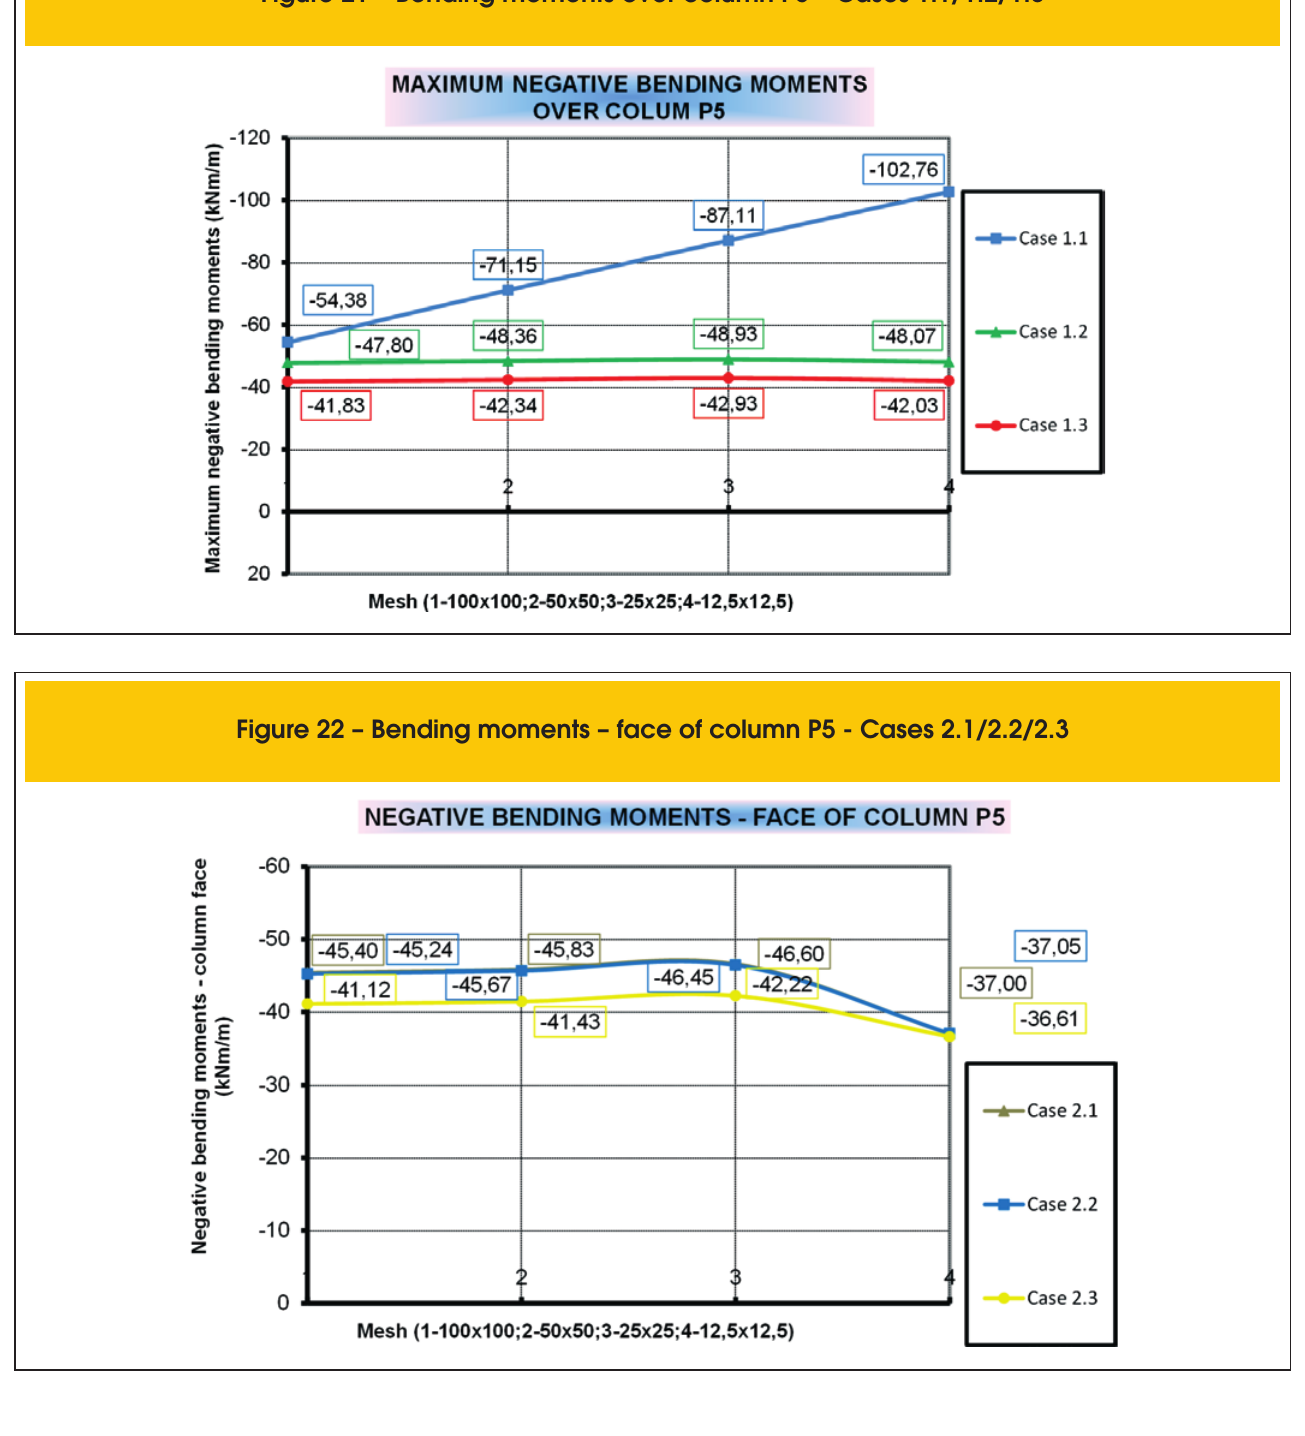
Figure 21 – Bending moments over column P5 – Cases 1.1/1.2/1.3